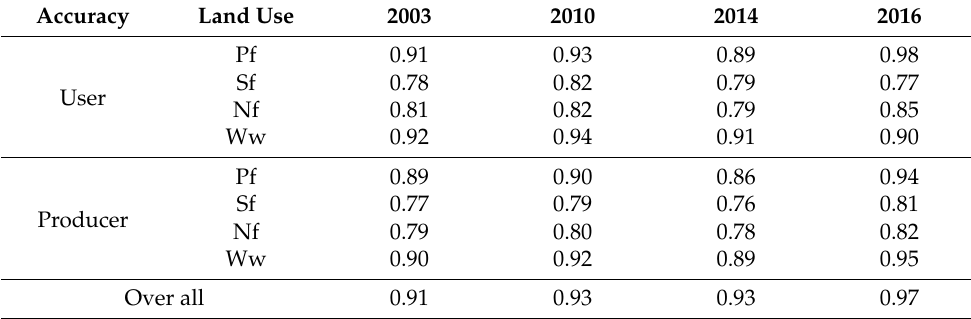
Table 4. Accuracy assessments of land cover